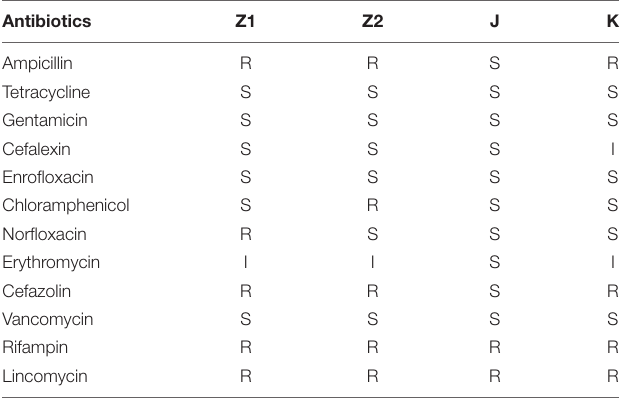
TABLE 3 | The antibiotic susceptibility results of all strains.